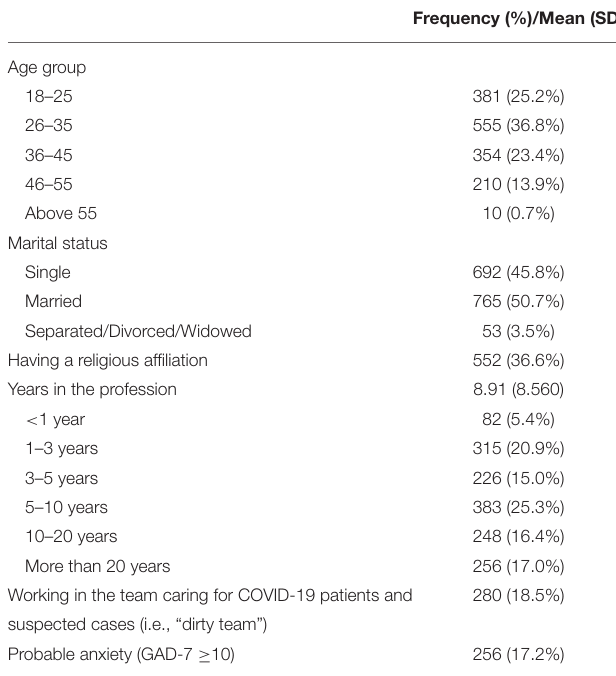
TABLE 1 | Characteristics of the participants ( N =